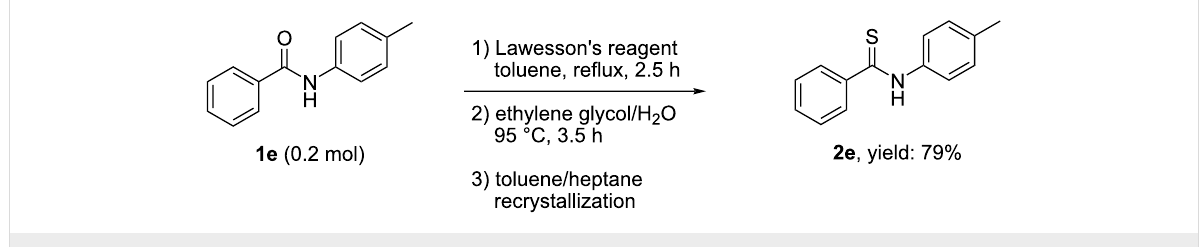
Figure 3: Modified process for the synthesis of 2e via phase separation.